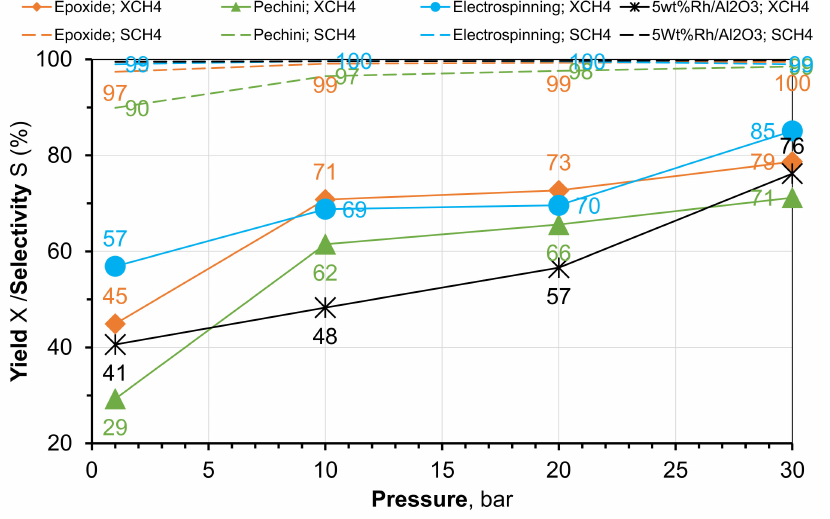
Figure 1. Methanation of CO 2 over fresh nickel–cerium bimetallic oxides at 300 ◦ C: pressure and method effect on the yield to CH 4